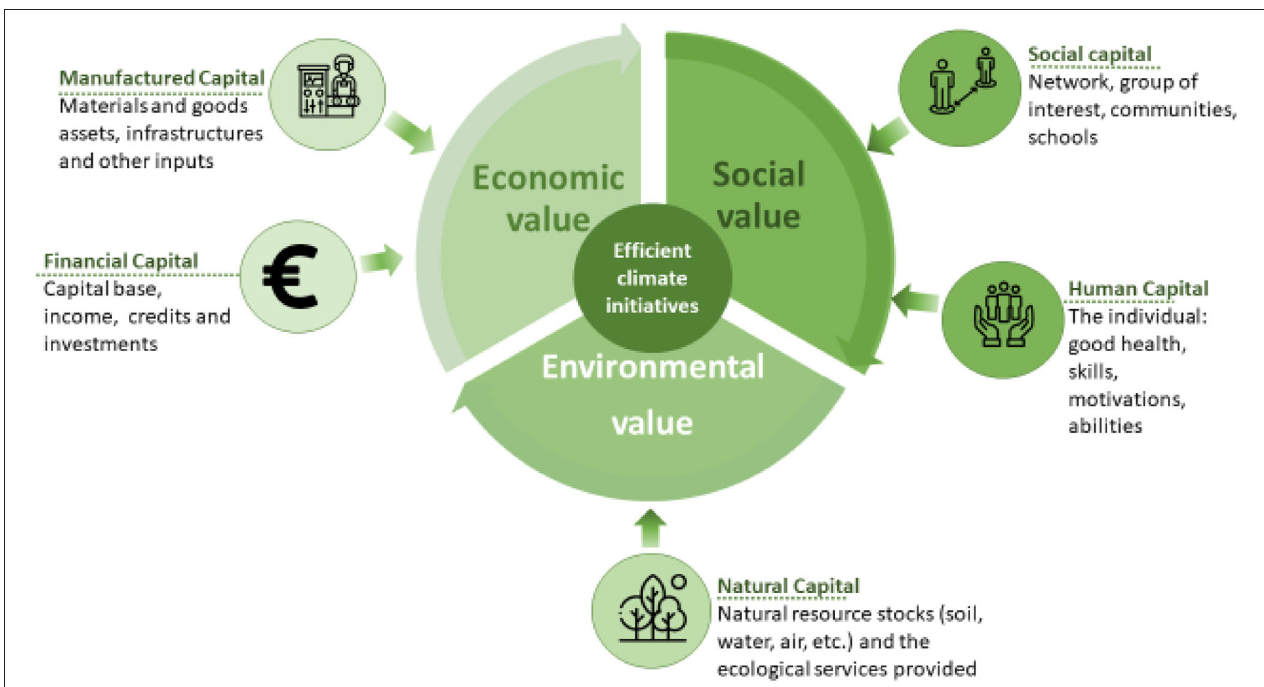
FIGURE 4 | The linkages between the key community systems and the 5 capitals